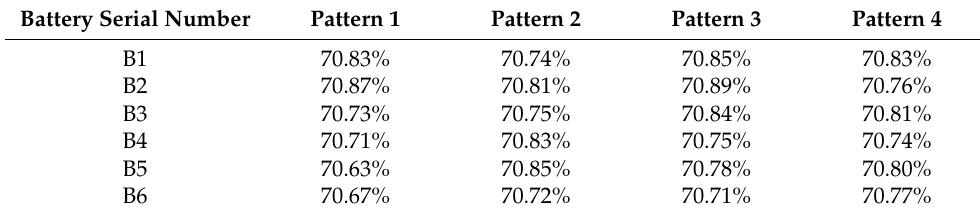
Table 4. Static equalization experimental data.